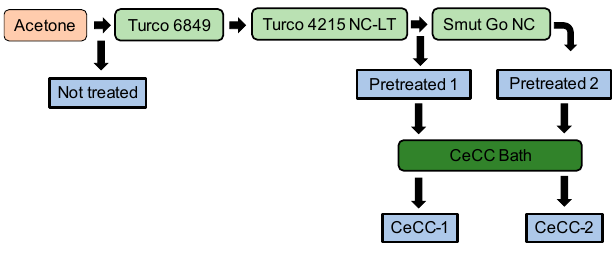
Figure 1. Sample preparation workflow.